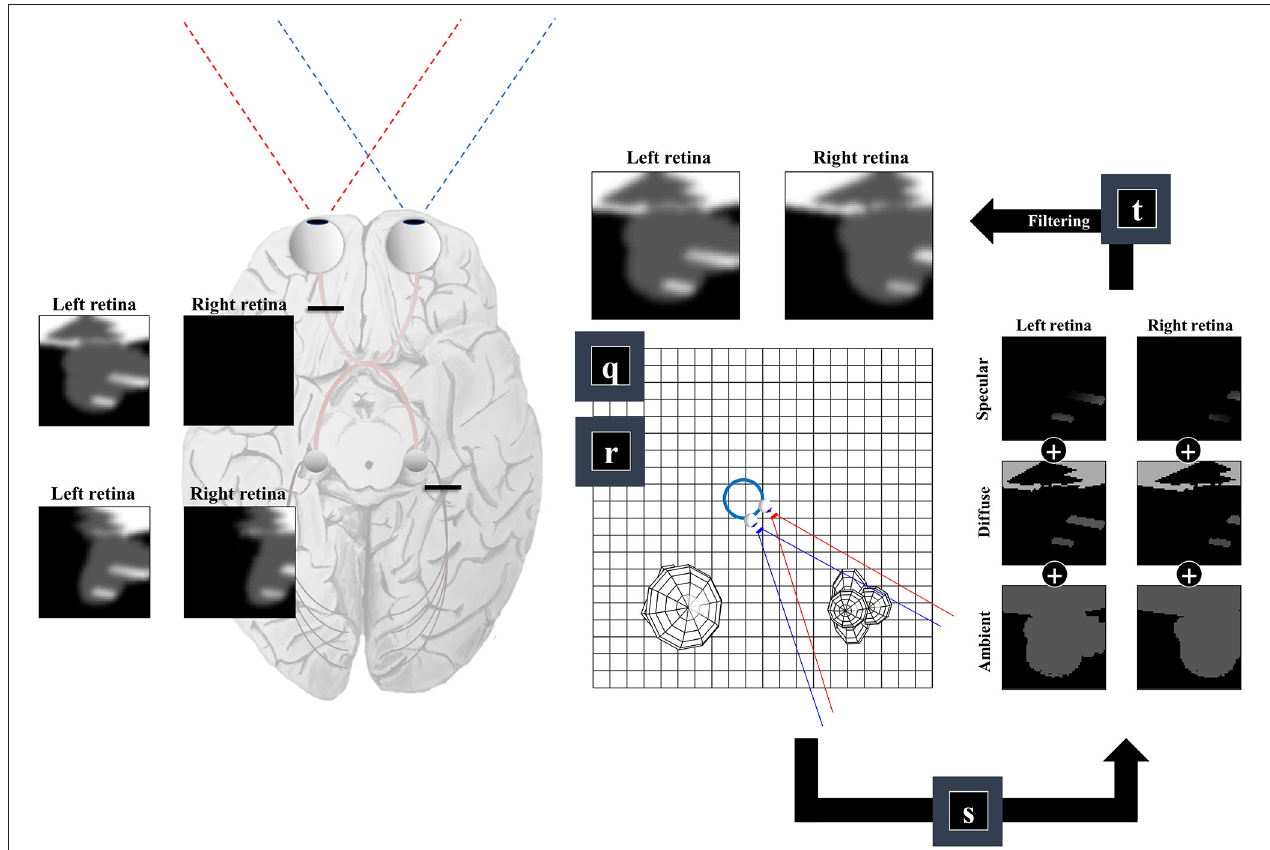
FIGURE 4 | The retinocortical pathway. This figure takes the results from Figures 2 , 3 and combines these to arrive at images in each retina. From factors r and q we have our field of view and the surfaces it captures. We can then project from each retinal cell (shown as pixels in the retinal images) to see whether any surface is encountered. For the first surface we reach, we combine the ambient, diffuse, and specular lighting components (factor s ). This depends upon factor b from Figure 1 , which provides a lighting direction. Once we have the sum of these lighting components, we apply a blurring (factor t ) to the image to compensate for the artificial high frequency components introduced by our simplifications. Practically, this is implemented by finding the coefficients of a 2-dimensional discrete cosine transform, multiplying this by a Gaussian function centered on the low frequency coefficients, and then performing the inverse transform. Note that the final image is inverted across the horizontal and vertical planes. This is due to the light reflecting off surfaces on the temporal visual fields being propagated to the retina on the nasal side, and vice versa (with the same inversion in the superior and inferior axis). The fact that the same surface can cause activation of both the right and left retina implies a divergence in the predictions made by parts of the brain dealing in surfaces (e.g., striate cortices) about retinal input. The graphic on the left illustrates the two sorts of visual field defect resulting from this divergence—either interrupting the influence of any surface on one retina (upper image) or interrupting the influence of a subset (e.g., the right half) of all surfaces on either retina (lower